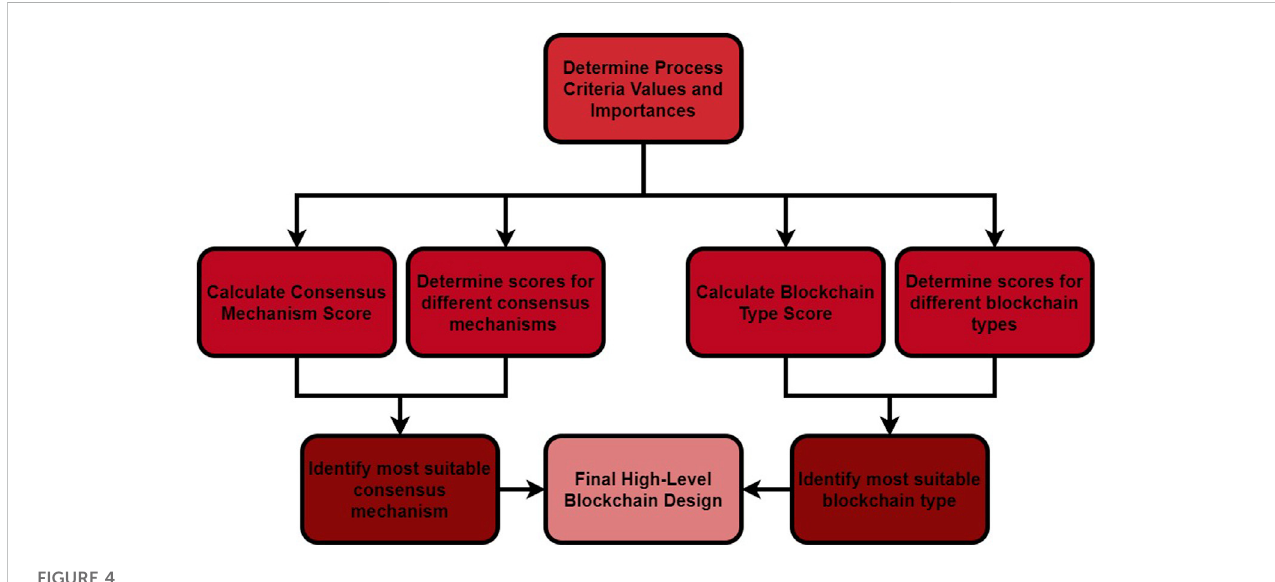
FIGURE 4 High-Level Blockchain Design